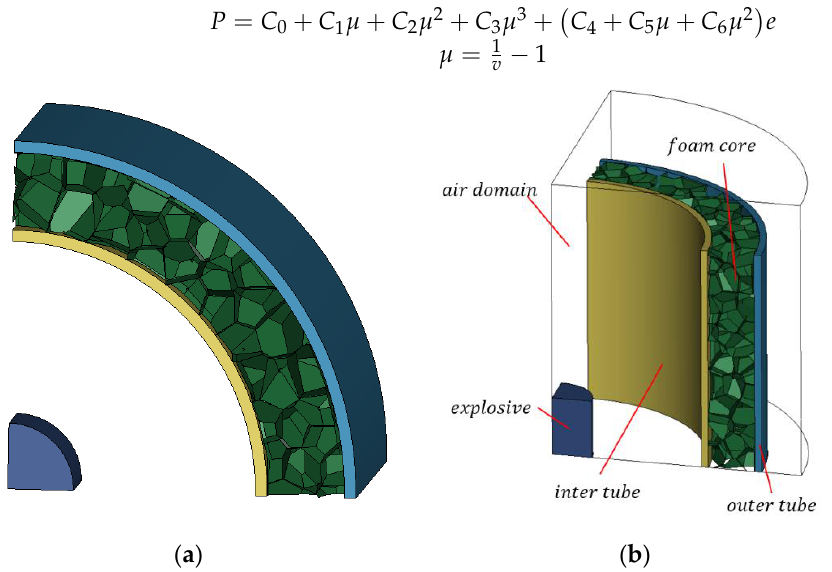
Figure 6. Computational model. ( a ) Schematic diagram of a foamed aluminum sandwich tube and ( b ) the finite-element model. Table 1. Material parameters of the Johnson–Cook model